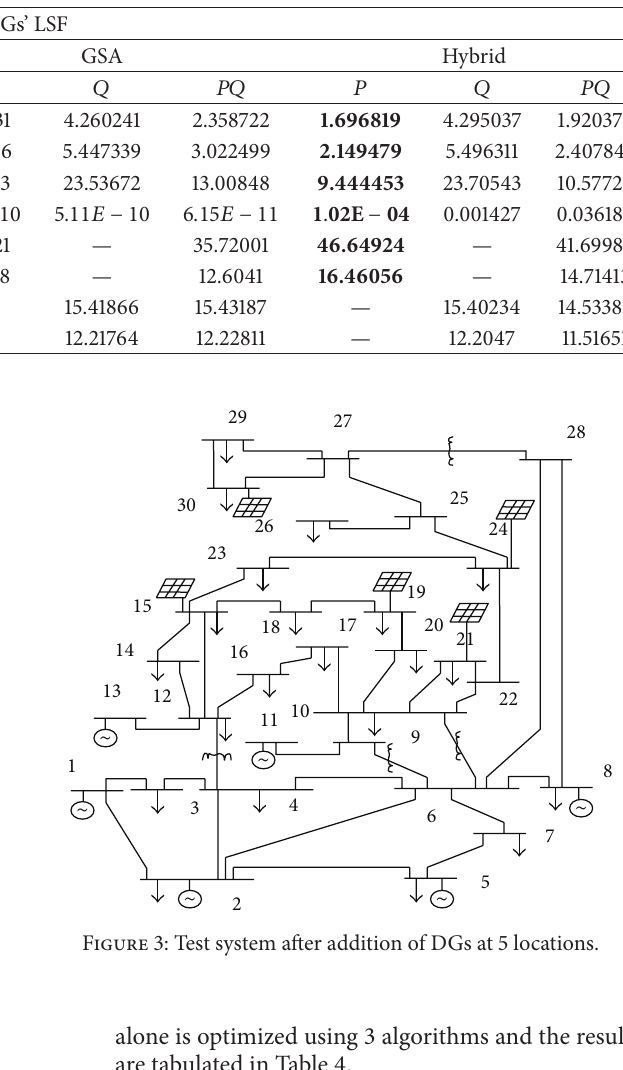
Table 3: Best outcome among all cases.